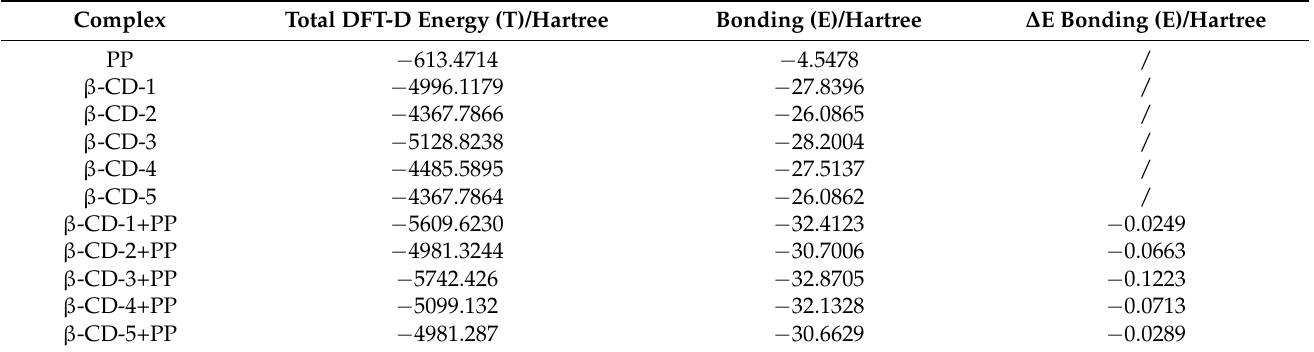
Figure 3. Calculated values of template–monomer interaction energies by theoretical calculation. Table 1. Δ Total DFT-D energy and Δ bonding E values for the templates and monomer complexes.